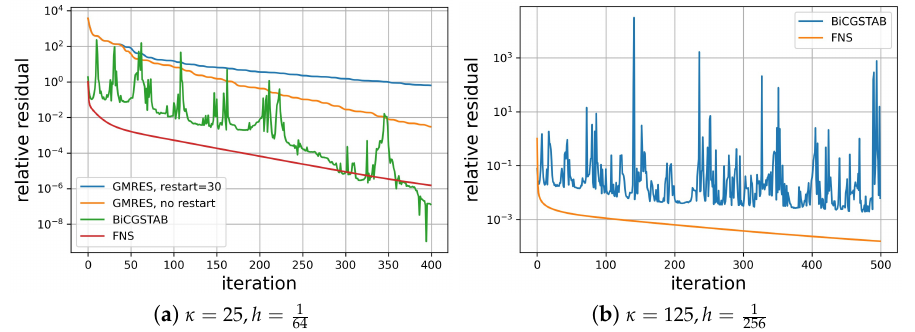
Figure 10. Change in relative residual for the FNS and other solvers when κ = 25 and κ = 125,